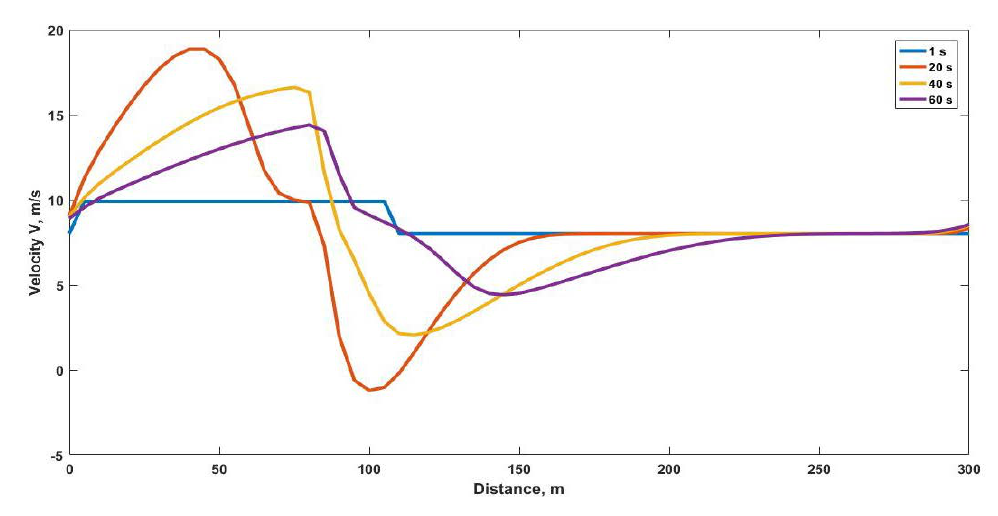
Figure 4. Velocity with the Payne–Whitham (PW) model on a 300 m circular road with C 0 = 10 at 1 s, 2 s, 4 s and 6 s. Table 4. Velocity and density with the PW model at 1 s, 2 s, 4 s and 6